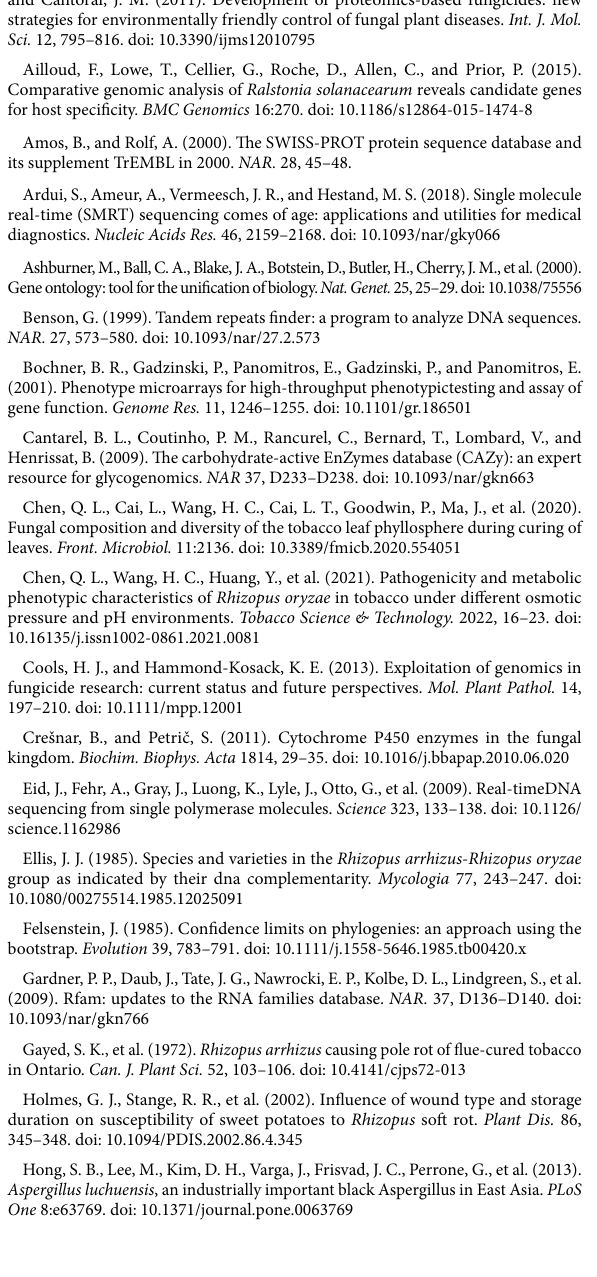
SUPPLEMENTARY FIGURE S1 Evolutionary relationships of Rhizopus oryzae. Phylogenetic tree showing the phylogenetic relationship amongst difference belonging to the species Rhizopus oryzae ( Rhizopus oryzae , also known as Rhizopus arrhizus ), is a filamentous fungus that is the most common cause of mucormycosis, also referred to as zygomycosis. An opportunistic pathogen, R. oryzae causes disease primarily in immunocompromised people, such as those with diabetes mellitus, cancer, or AIDS. R. oryzae is found in soil, decaying fruit and vegetables, old bread, and animal dung. It is used in the preparation of fermented foods and alcoholic beverages in Asia. R. oryzae is also a destructive pathogen that frequently causes tobacco pole rot in curing